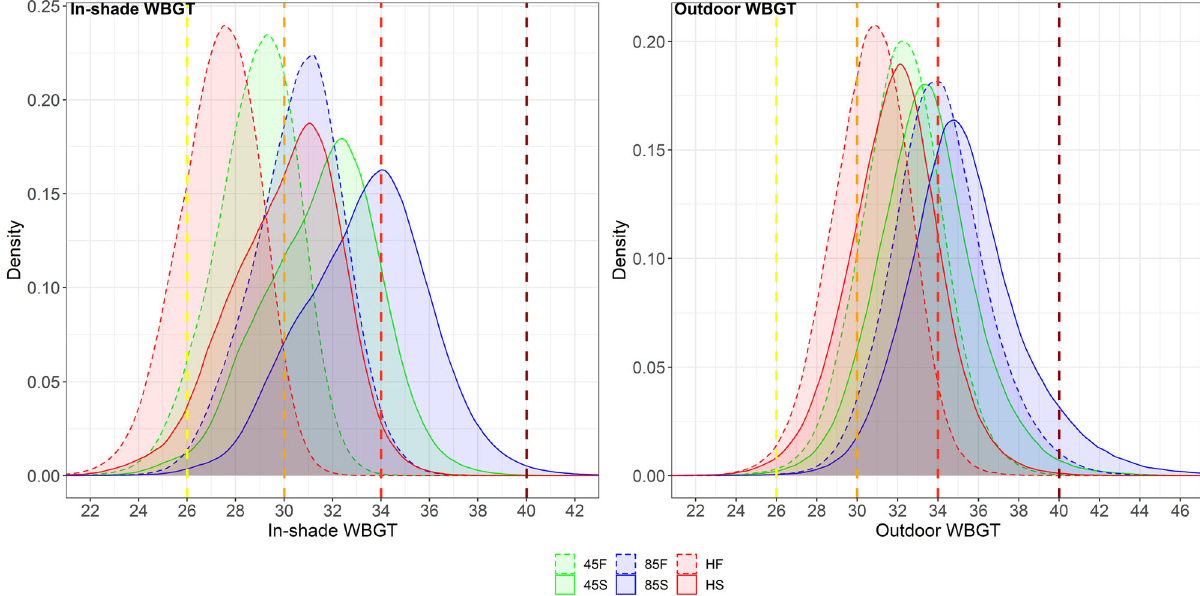
Fig. 2 Distribution of daily maximum in-shadow and outdoor WBGT values (°C). Distribution of daily maximum in-shadow and outdoor WBGT values (°C), according to Amazon rainforest savannization and global climate change scenarios for historical conditions (1980 – 2010), RCP4.5, and RCP8.5 at the end of the century (2071 – 2100). Global warming scenarios (Historical – H, RCP4.5 – 45, RCP8.5 – 85) and land-use scenarios (Forested – F and Savannah – S). Risk of heat stress: WBGT ≥ 26 °C and < 30 °C: moderate risk to human health (dashed yellow line); WBGT ≥ 30 °C and <34 °C: high risk to human health (dashed orange line); WBGT ≥ 34 °C: extreme risk to human health (dashed red line); and WBGT ≥ 40 °C: risk to survivability (dashed dark red